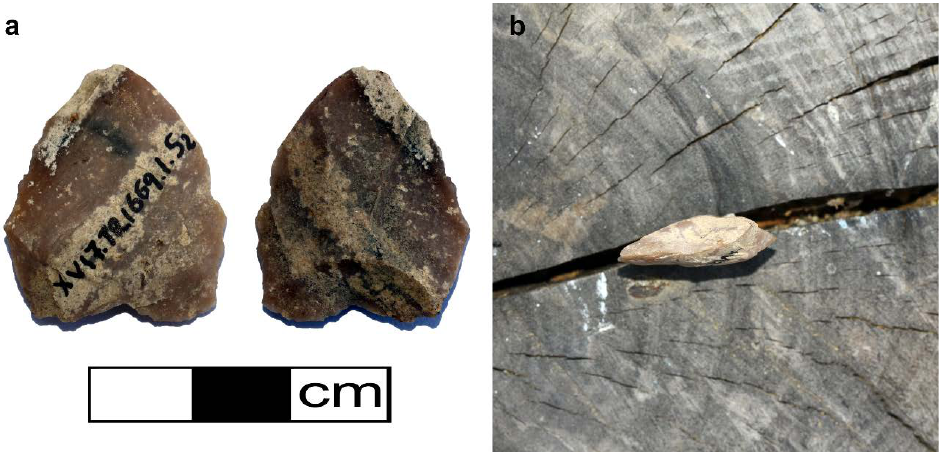
Figure 4. Lithics currently under study: ( a ) Arrowhead on both sides; ( b ) arrowhead side-view on tree-trunk stump (Images by Charalambos Paraskeva).